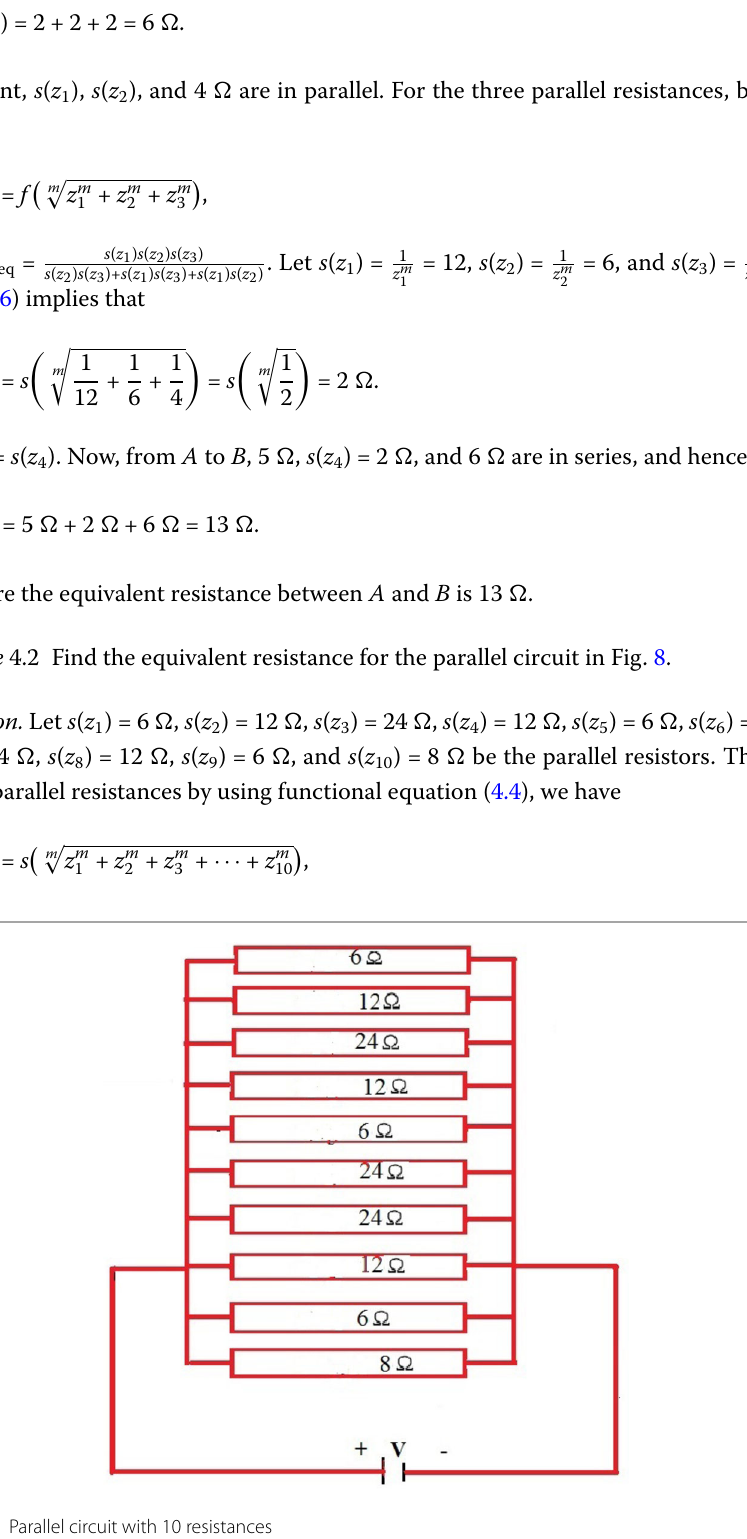
Figure 8 Parallel circuit with 10